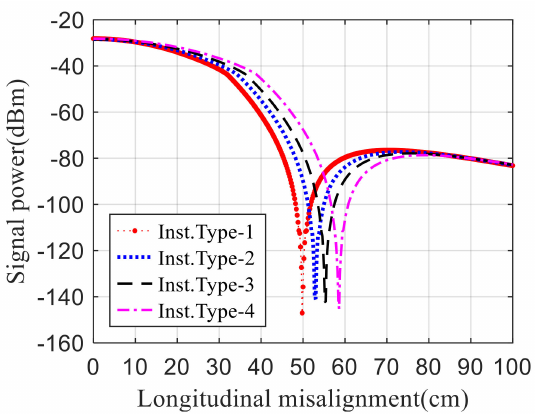
Figure 22. Variation of uplink received signal power with different installation modes (passive